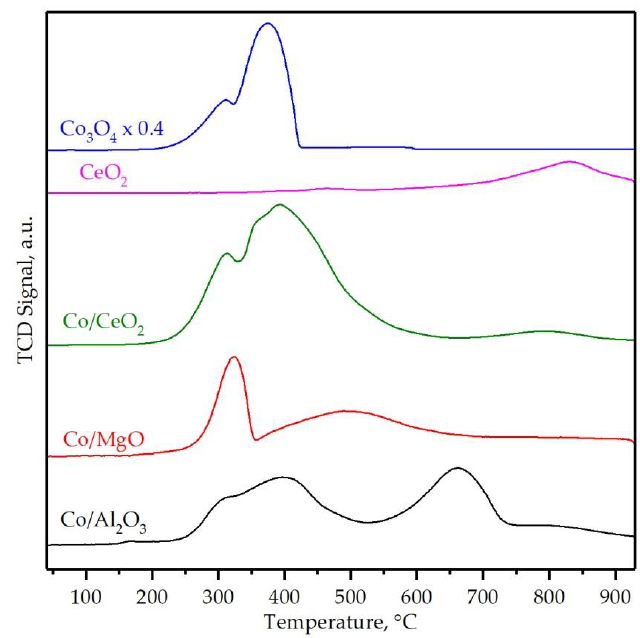
Figure 5. Temperature-programmed reduction with hydrogen (H 2 -TPR) profiles of the supported cobalt catalysts. Table 2. Redox properties of the supported cobalt catalysts derived from TPR analysis with H 2 and CH 4 .